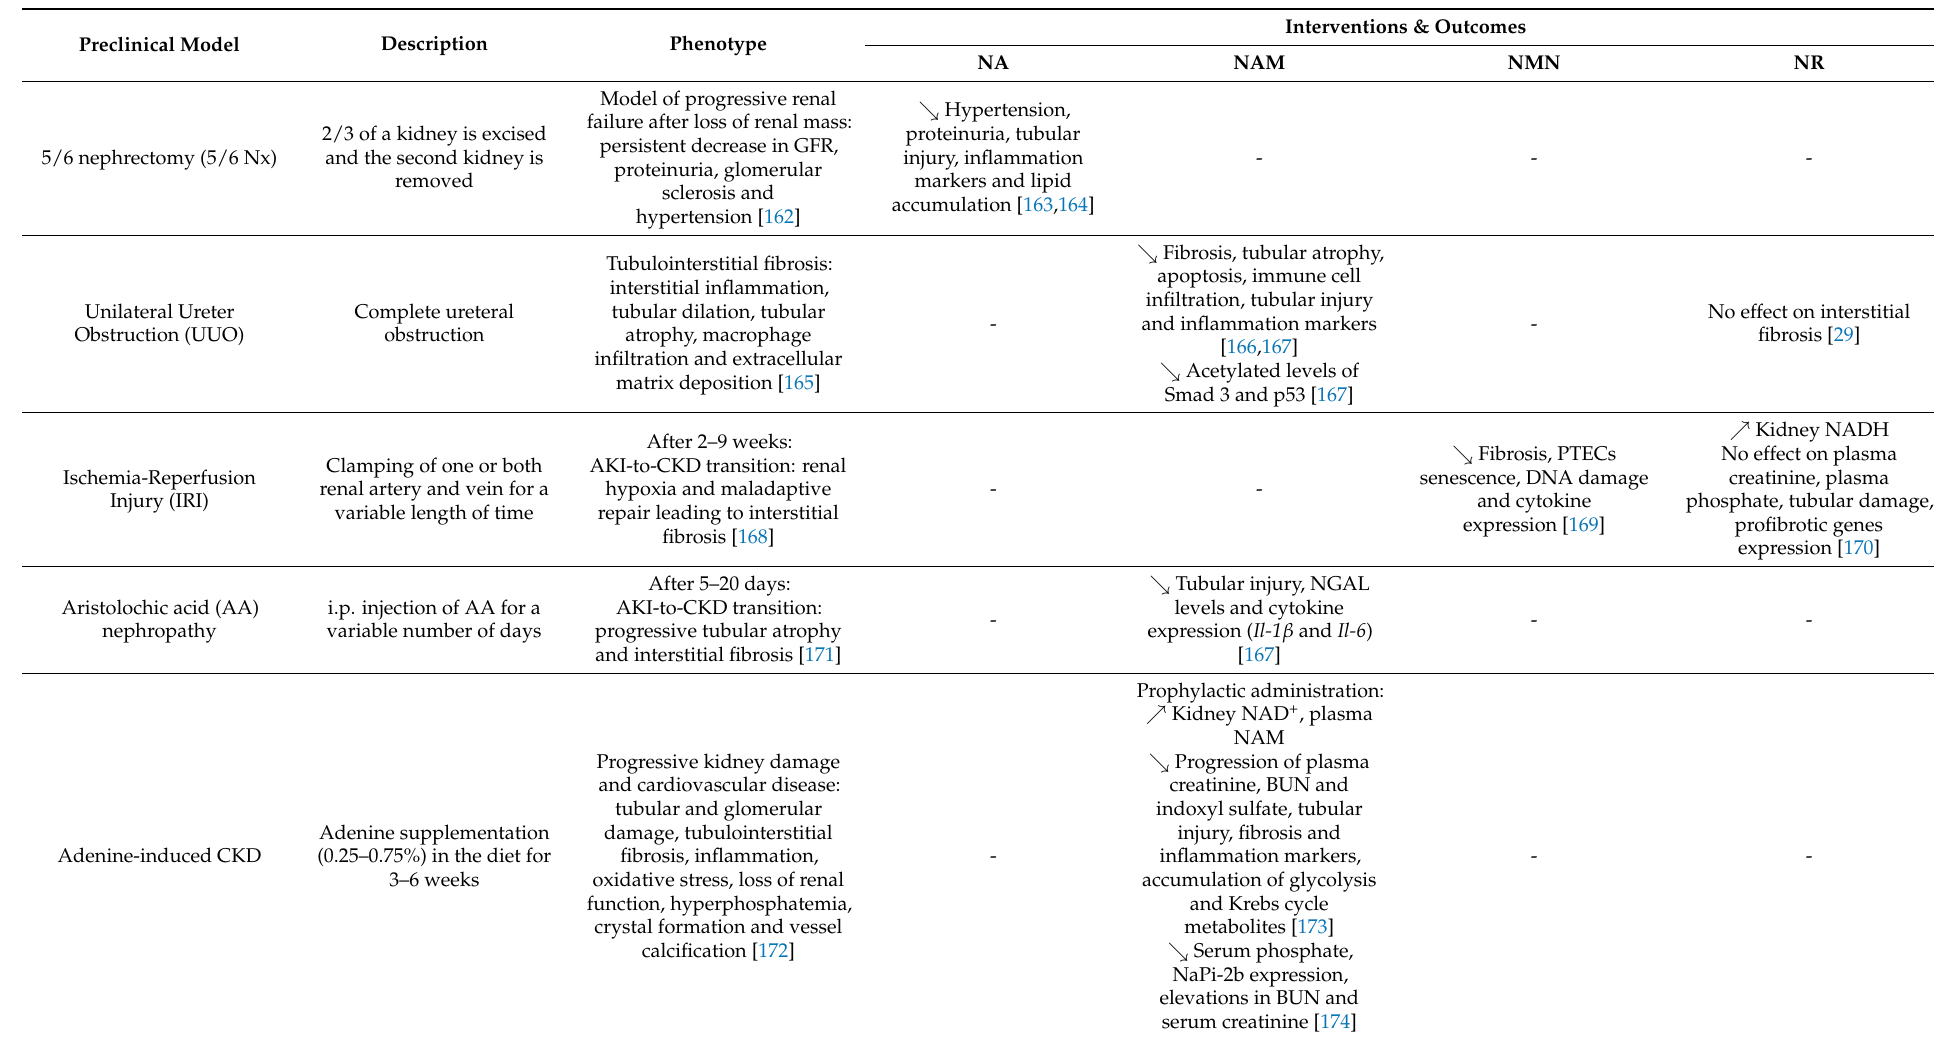
Table 1. Premature renal aging and CKD preclinical models used for NAD + boosting